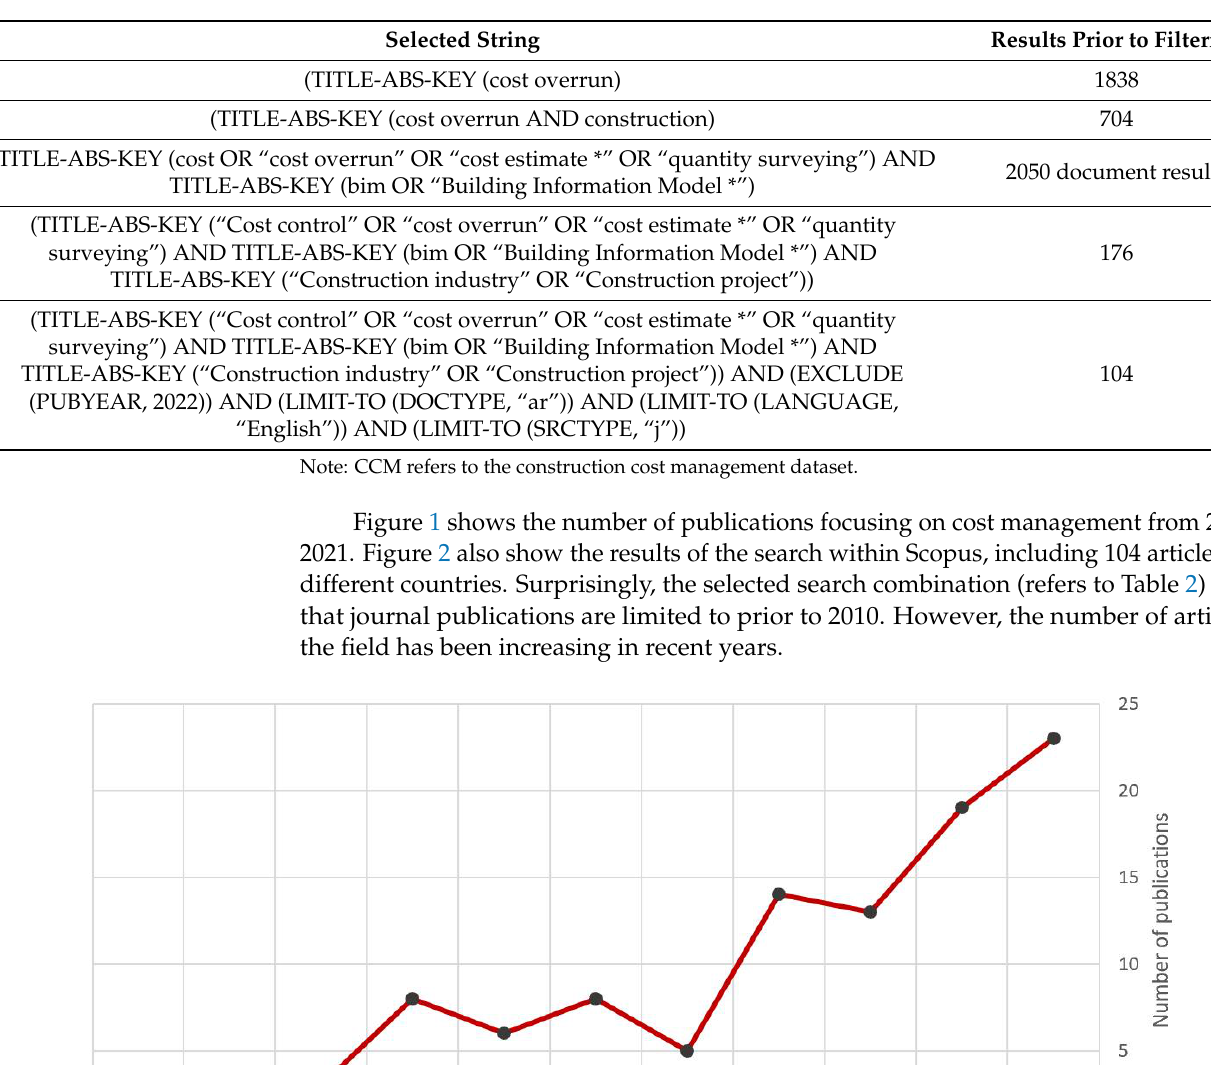
Table 2. Examples of query strings in databases and results.